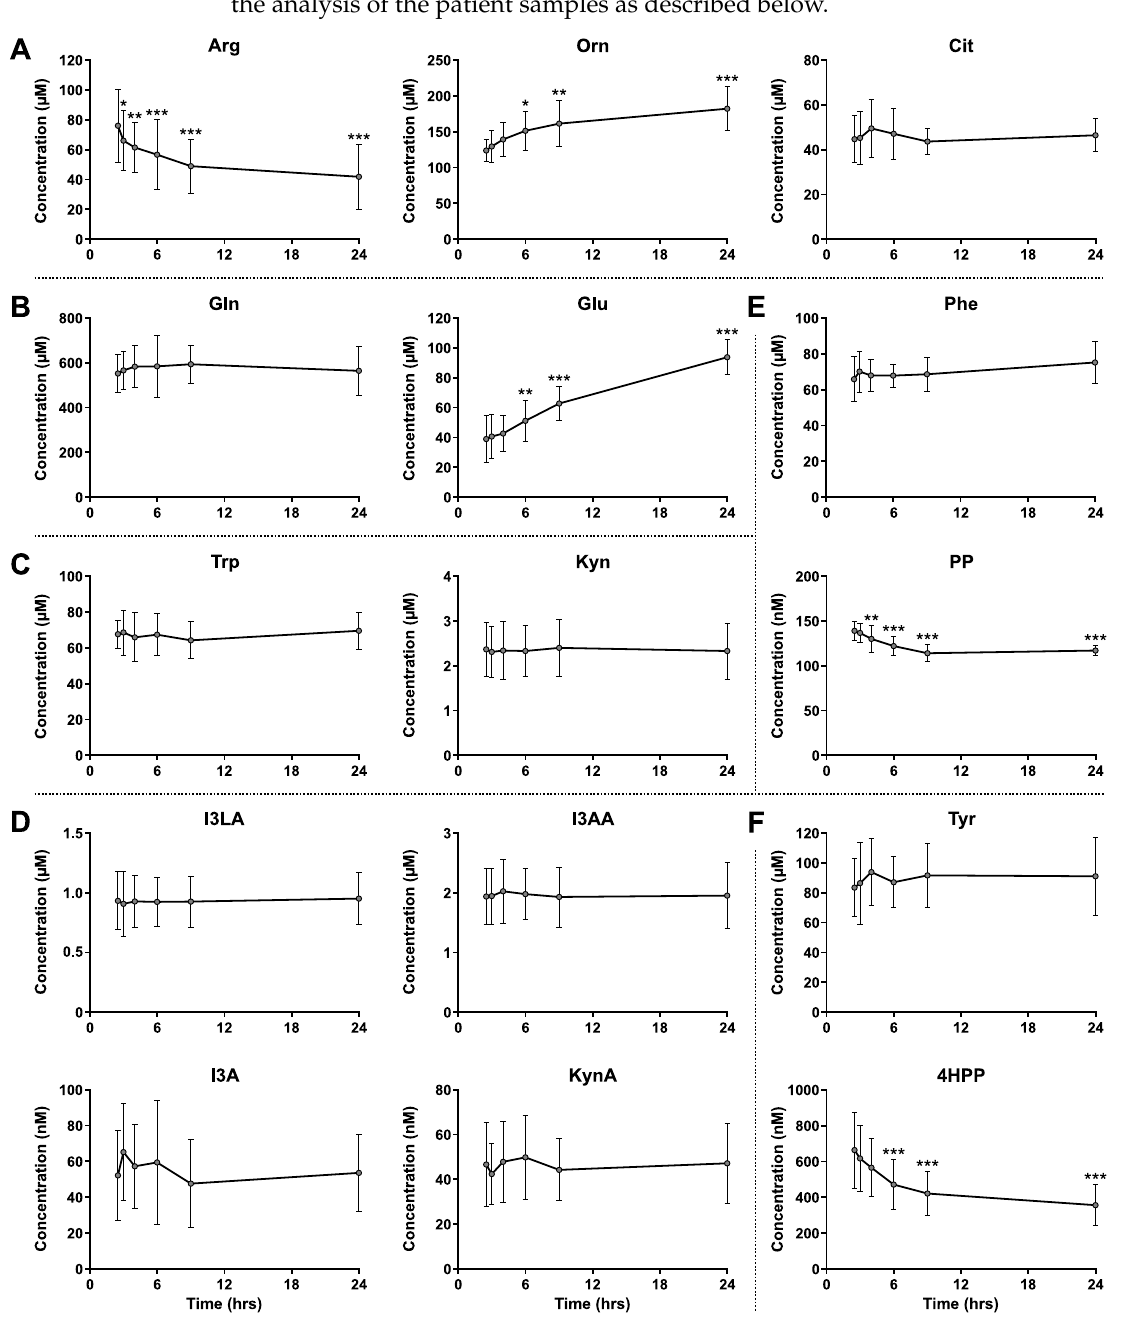
Figure 2. Stability of amino acid and metabolite levels in healthy donor blood stored at room tem- perature prior to plasma separation. Amino acids and metabolites related to metabolism of ( A ) Arg, ( B ) Gln, ( C , D ) Trp, ( E ) Phe and ( F ) Tyr. Amino acid and metabolite levels were determined by LC-MS/MS analysis and are expressed as mean ± SD of six individual donors. I3LA, I3AA, I3A and KynA are downstream metabolites of the unstable indole-3-pyruvic acid (I3P). One-way repeated mea- sures ANOVA showed an overall effect of time on Arg, Orn, Glu, PP and 4HPP levels (all p < 0.001). Significant results of Dunnett’s multiple comparisons test with the first timepoint as reference group are indicated in the graphs. * p ≤ 0.05; ** p ≤ 0.01; *** p ≤ 0.001. 4HPP: 4-hydroxyphenylpyruvic